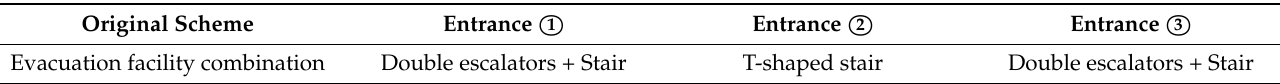
Table 2. Combination form of original evacuation facilities.